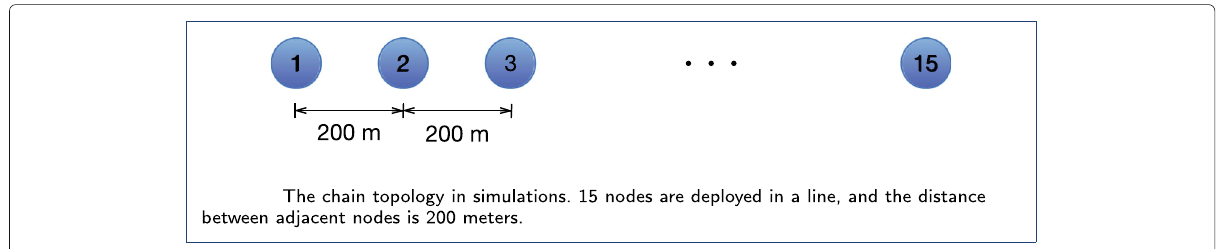
Fig. 1 The chain topology in simulations. Fifteen nodes are deployed in a line, and the distance between adjacent nodes is 200